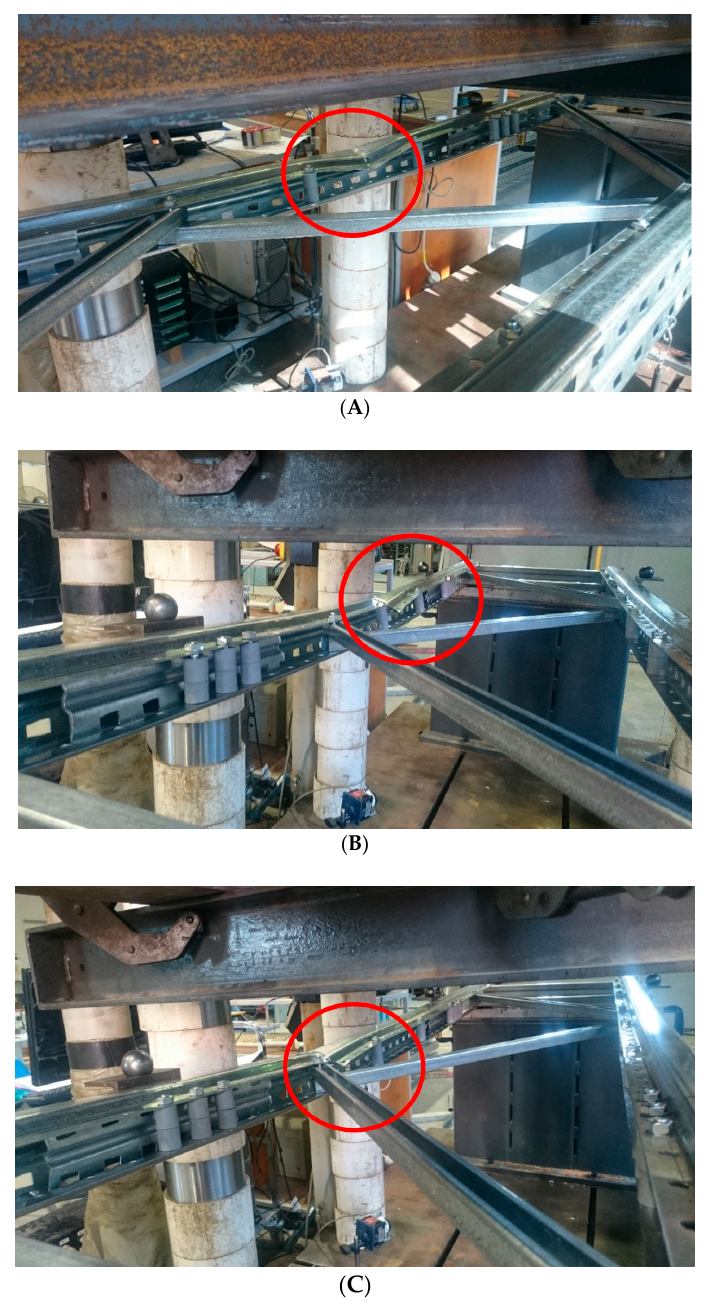
Figure 13. The observed failure modes for reinforced specimens with 300 mm reinforcing space during the major axis test: ( A ) 300RMJM-test1; ( B ) 300RMJM-test2; ( C ) 300RMJM-test3.